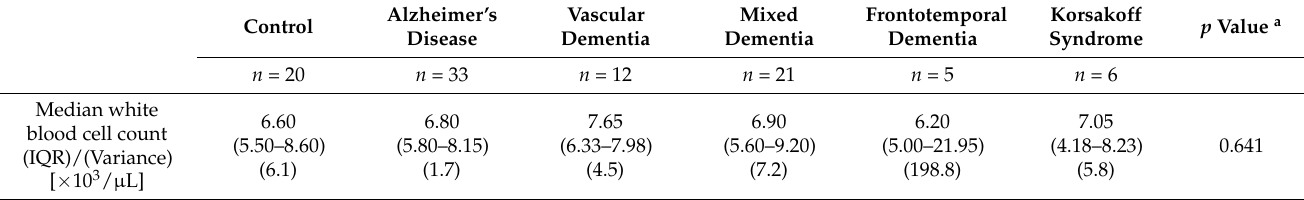
Table 2. White blood cell populations, platelet counts, and C-reactive protein levels in demented and non-demented